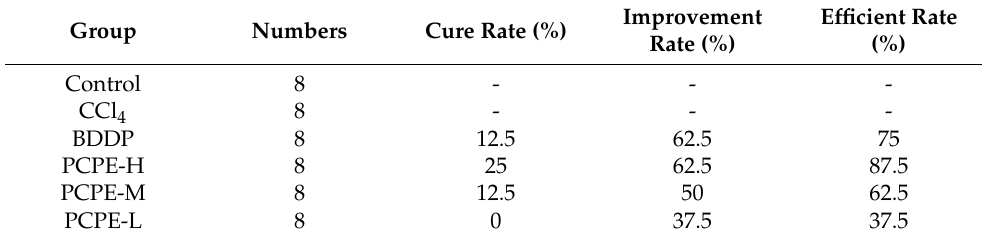
Table 2. Effect of PCPE on ALI dogs.